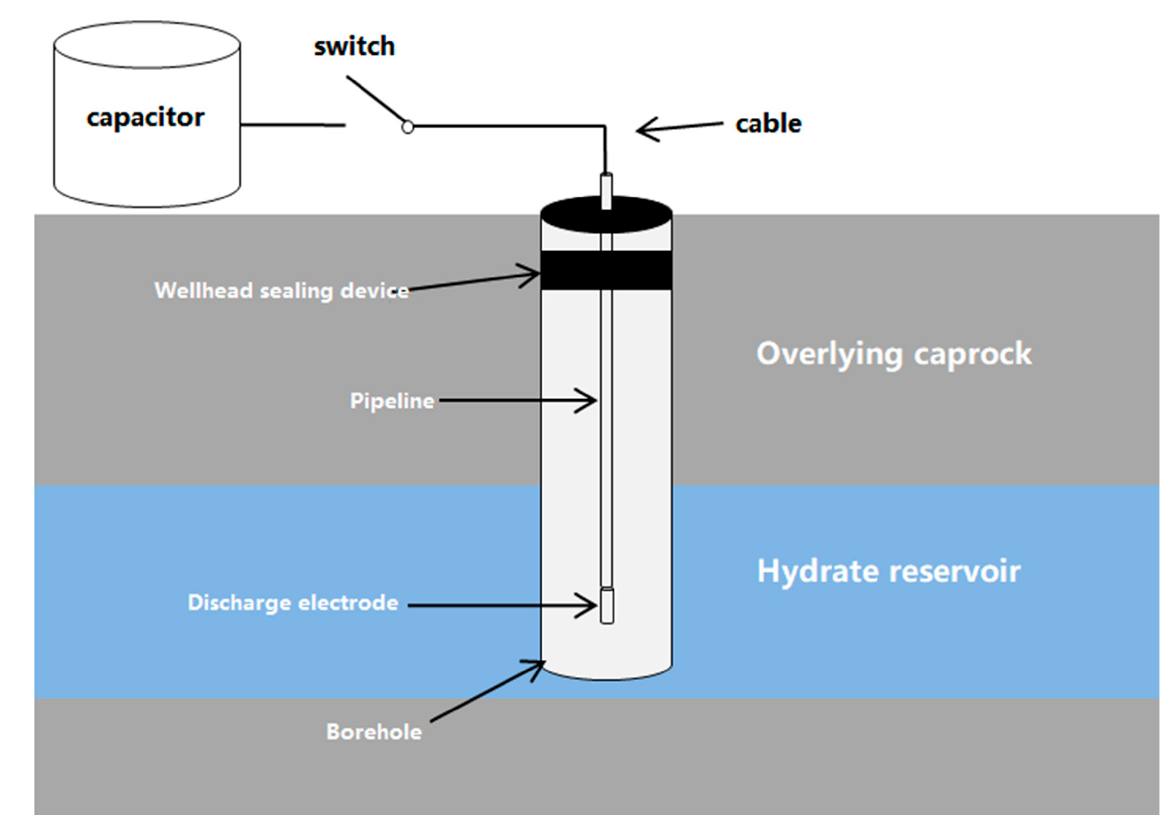
Figure 9. Schematic diagram of high-pressure electro-hydraulic pulse stimulation operation.